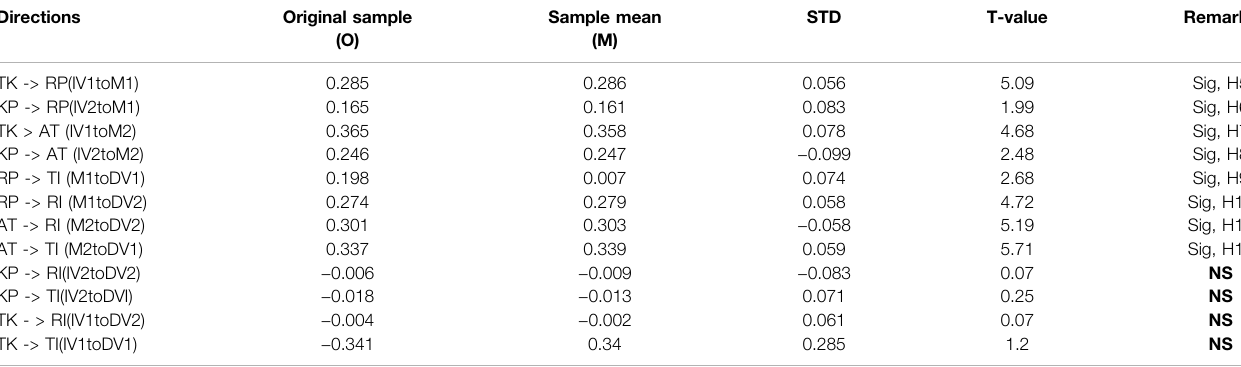
TABLE 6 | Mediation effect. Directions